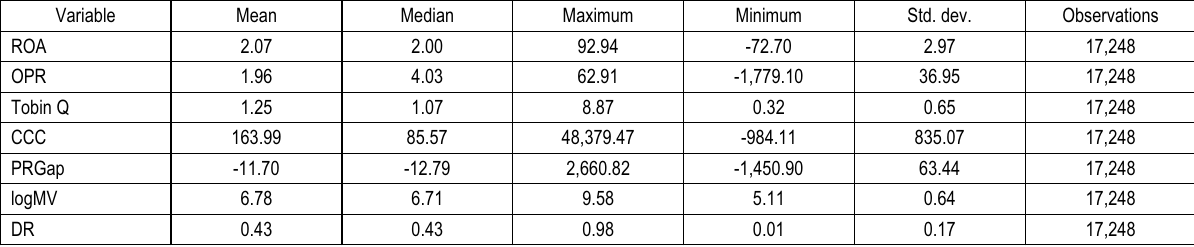
Table 3. Summary statistics of regression variables